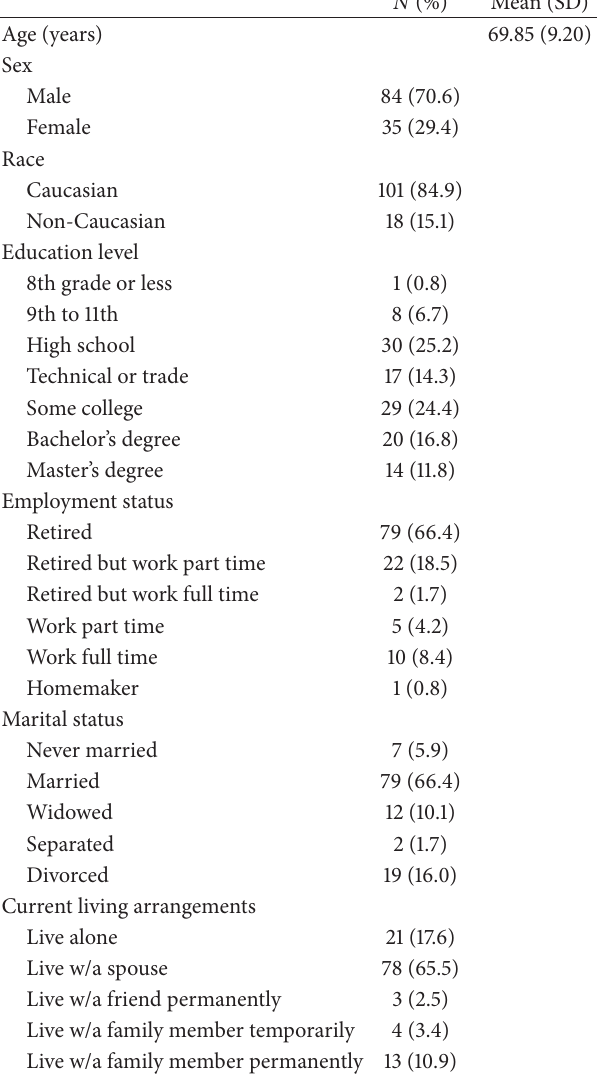
Table 1: Demographic characteristics ( 𝑛 = 124